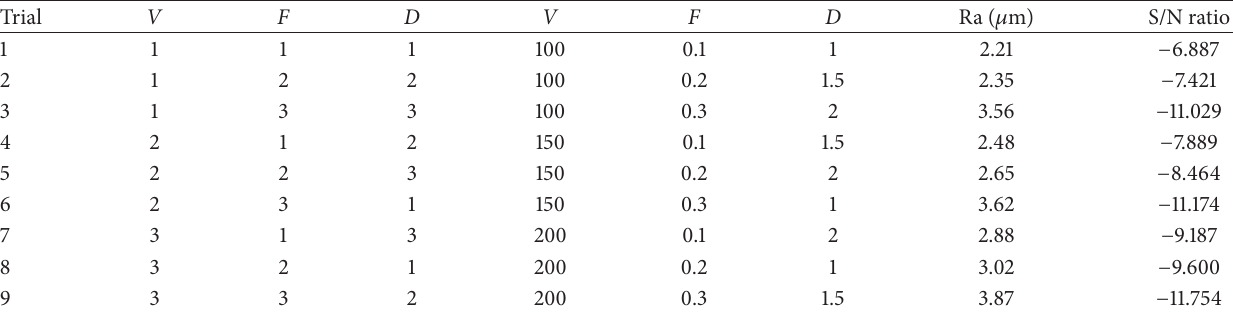
Table 11: Experimental result of surface roughness for Al6061/12 wt.% Al 2 O 3 /6wt.% MoS 2 .